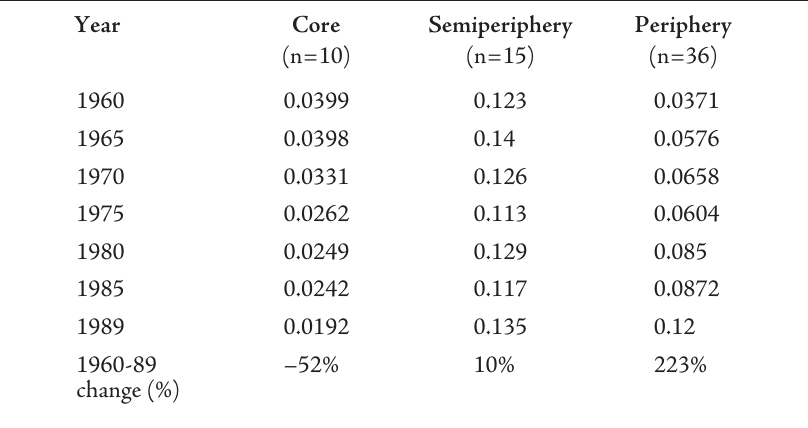
Table 8 – Variance of logged GDP per capita for three zones of the world- economy (PWT data; weighted